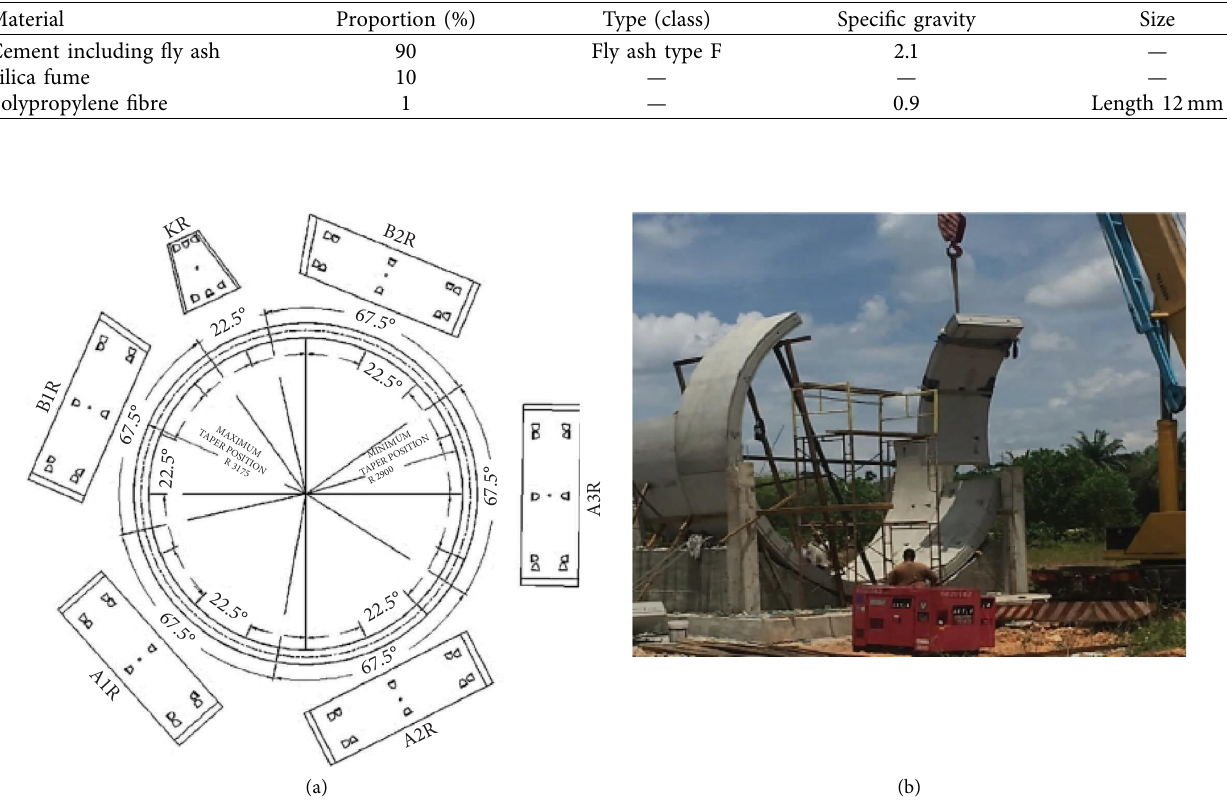
Figure 1: (a) Elevation of the ring and (b) assembling the segments into rings